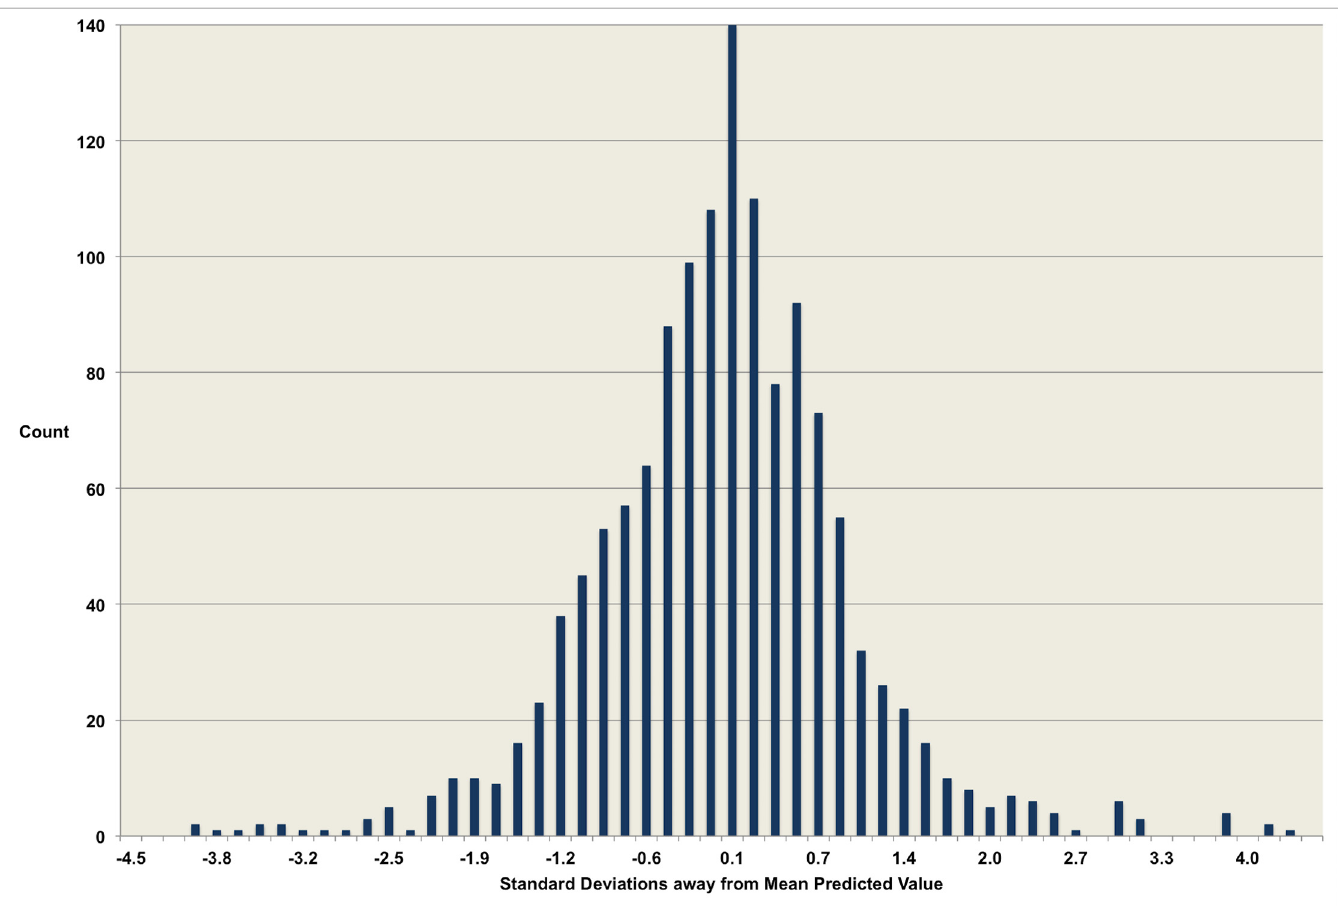
Fig 3. Residual analysis. The residuals are the variations in log-adjusted observed values from the log-adjusted age-related mean value predicted by the model. The residuals have excellent goodness of fit to an ideal Gaussian curve (r 2 = 0.99). 71% of the residuals are within one standard deviations (SD) of the mean, 94% within 2 SD, and 98% within 3SD. The percentages for an ideal Gaussian distribution are 68%, 95% and 99%